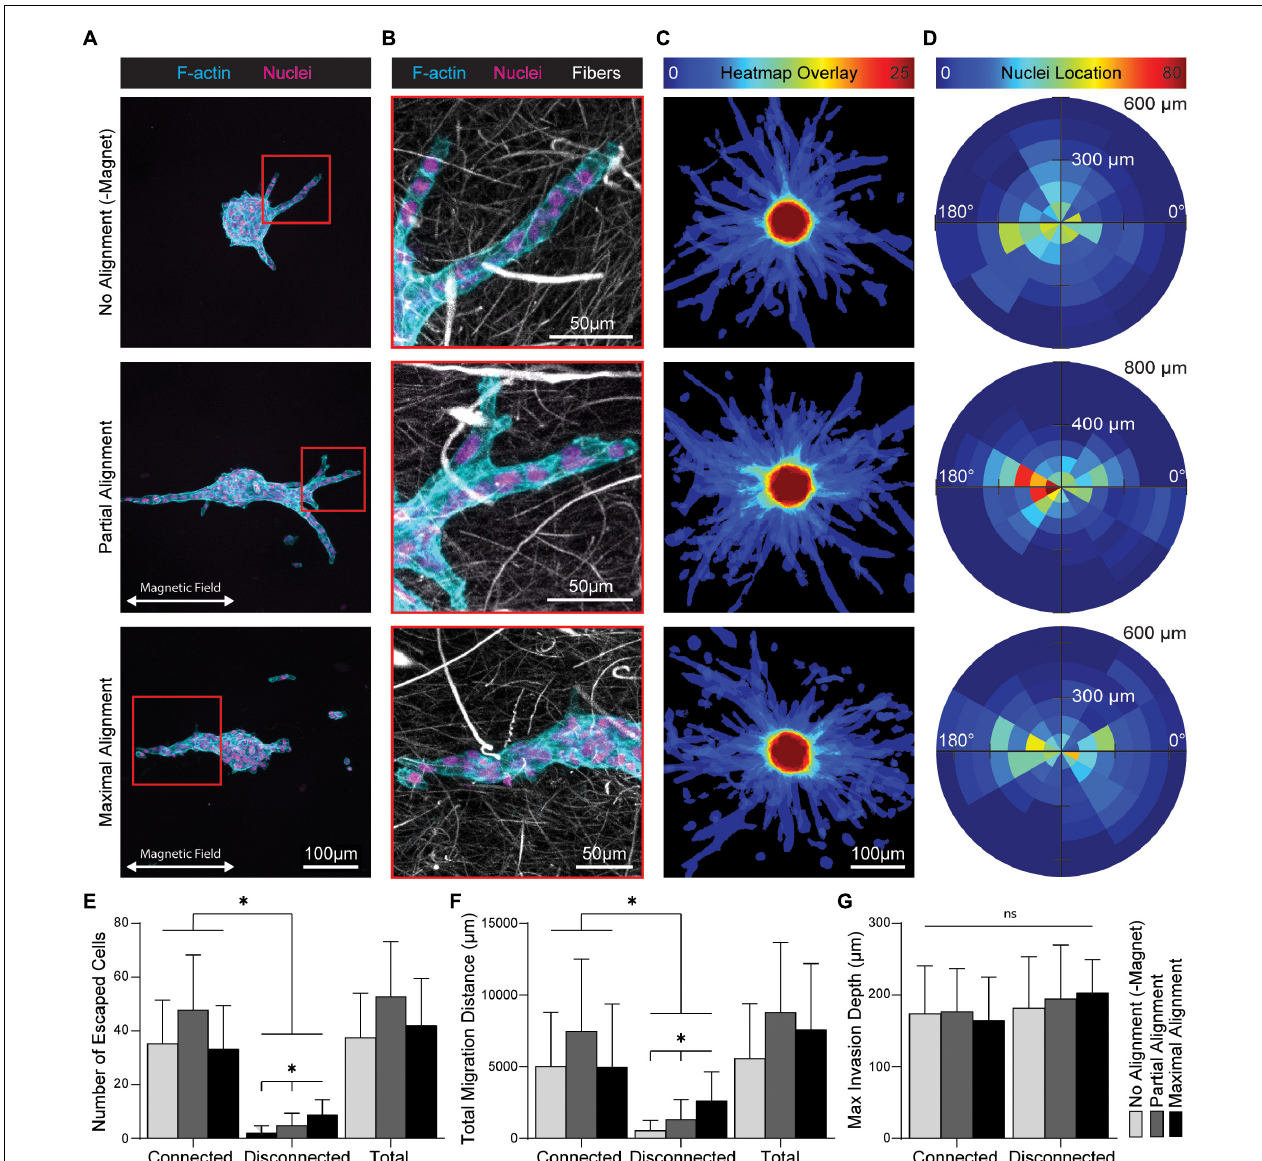
FIGURE 7 | Fiber alignment biases migration direction from multicellular MCF10A spheroids and induces cell-cell breakage events. (A) Fluorescent images of cell outgrowth from multicellular MCF10A spheroids encapsulated in DVS hydrogel composites after 6 days. (B) Higher magnification image including DVS fibers from location depicted by inset in (A) . (C) Heatmap overlays created by an aggregate sum of binarized actin channels and (D) rose plots of migratory cell nuclei location for n = 25 spheroids per condition. Quantification of (E) total number of migratory cells and (F) total migration distance stratified by outgrowth contiguity with the spheroid. (G) Maximum invasion depth of individual outgrowths stratified by contiguity with the spheroid. All data presented as mean ± SD; ∗ indicates a statistically significant comparison with p <